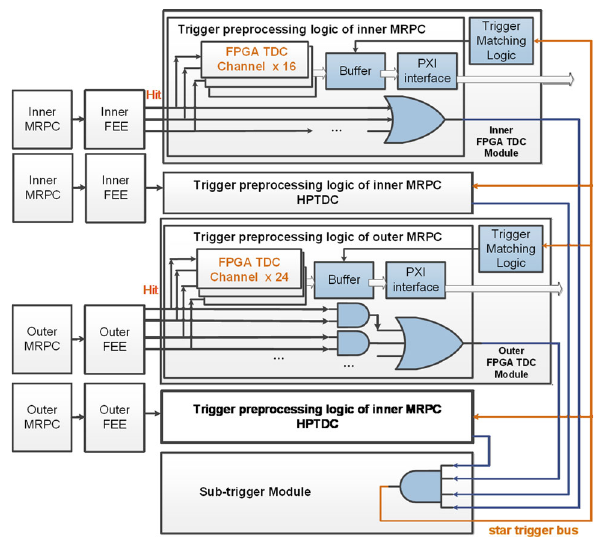
Fig. 17 Trigger processing and data readout